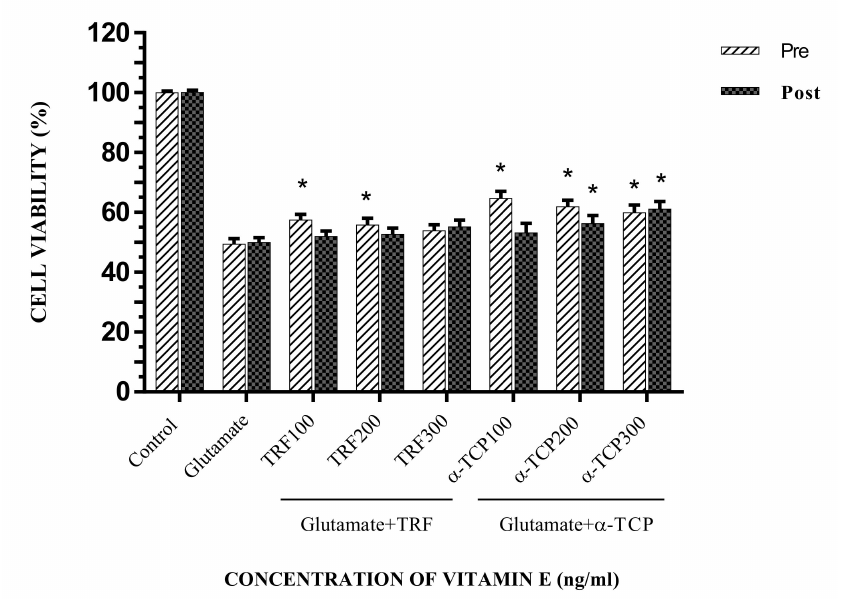
Figure 3. The effect of pre- and post-treatment with TRF and α -TCP against 100 mM glutamate on cell viability in astrocytes. Data represent the mean ± SEM of three independent experiments ( n = 3 in each experiment). * p < 0.05, TRF- and α -TCP-treated groups compared with the glutamate-treated group. This shows that TRF and α -TCP, at a low concentration (100 ng/mL) in pre-incubation, and at a high concentration (300 ng/mL) in post-incubation, exerted potential prophylactic effects against glutamate toxicity in the primary astrocyte.